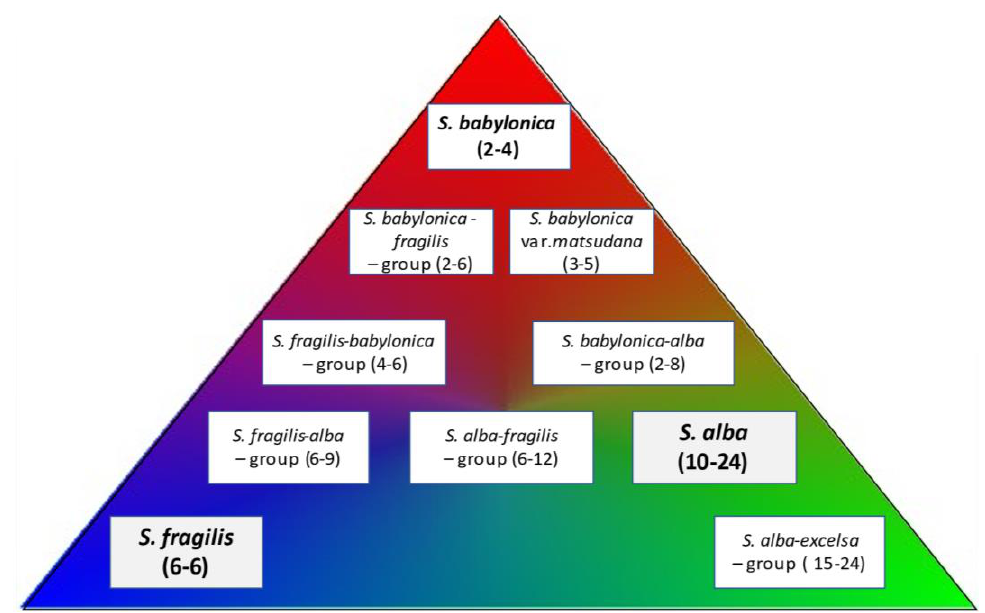
Figure 7. Diagrammatic representation of the variation of the ovule number in S. babylonica—S. fragilis—S. alba complex: the pure species and intermediate variants.